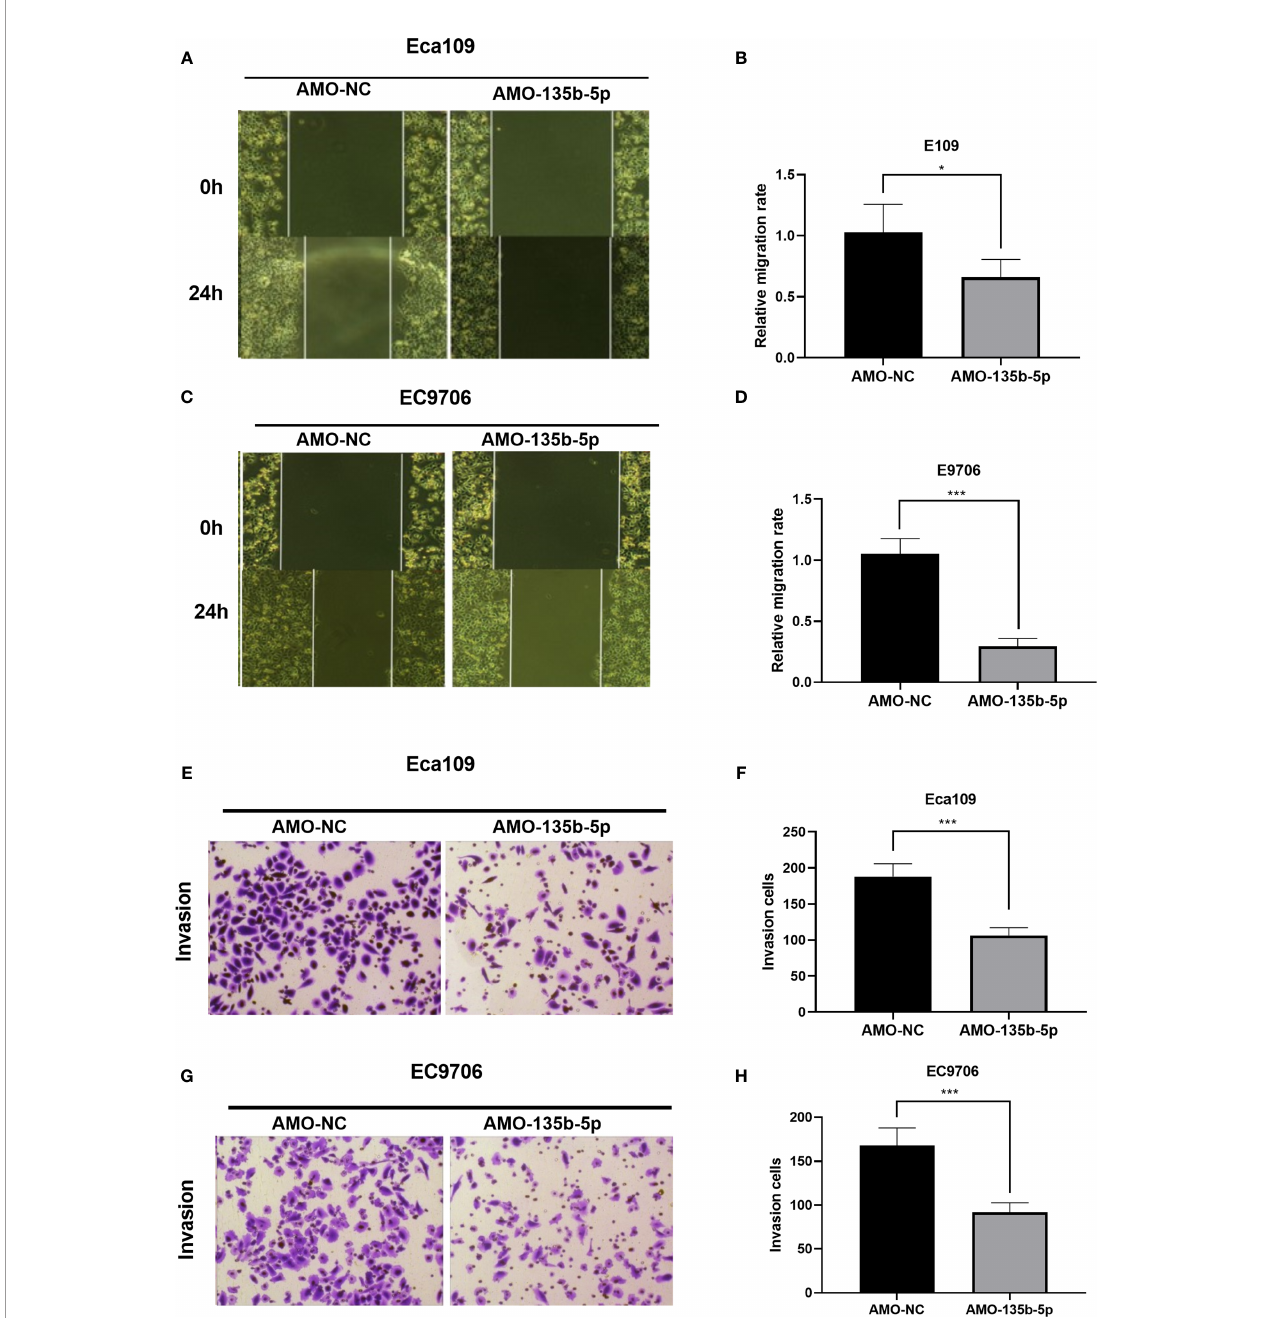
FIGURE 3 | Downregulation of miR-135b-5p weakened migration and invasion ability in Eca109 and EC9706 cells. (A – D) Wound healing assay con fi rmed that miR-135b-5p inhibition restrained cell migration in Eca109 and EC9706 cells, statistical analyses were showed accordingly, magni fi cation ×40. (E – H) Transwell assay evaluated that decreased miR-135b-5p expression abrogated invasion of Eca109 and EC9706 cells, magni fi cation ×200. (*p < 0.05, ***p <